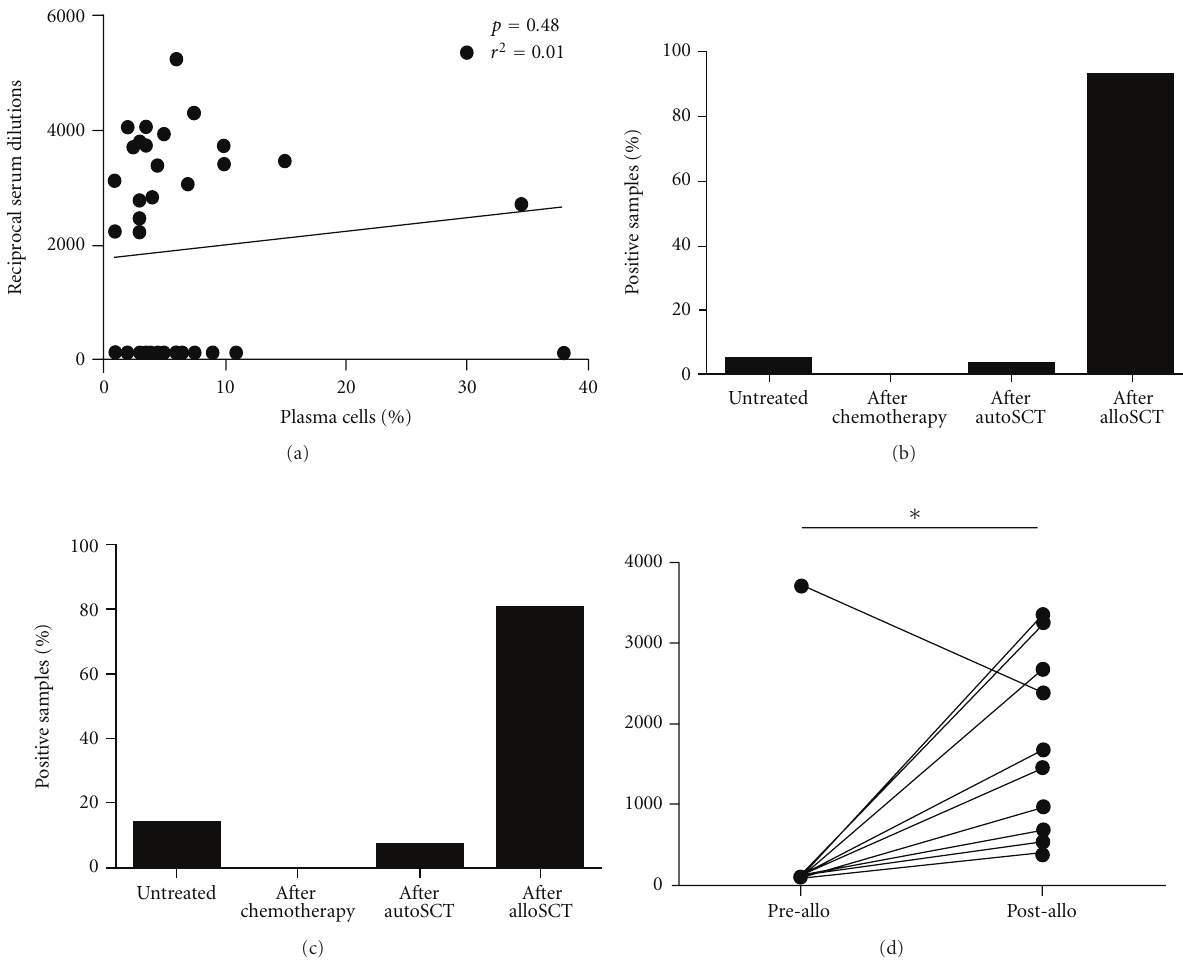
Figure 4: (a) Correlation analysis between the percentage of plasma cells found in the BM of MM patients with the corresponding SOX2- specific antibody titers. For some patients several samples from di ff erent time points were analyzed. No significant correlation was found between these two parameters ( P = 0 . 4826, r = 0 . 01153). (b) Treatment-dependent distribution of SOX2-positive samples and SOX2- positive patients. 92% (63 of 68) of all SOX2-antibody-positive samples were collected after alloSCT, while 4% (3 of 68) and 2.9% (2 of 68) were collected at time of diagnosis or after chemotherapy, respectively. 80% of SOX2-antibody-positive patients had received alloSCT as maximum treatment, while 13% (2 of 15) and 7% (1 of 15) were untreated or had received autoSCT, respectively. (c) Comparison between SOX2-specific antibody titers before and after alloSCT. Mean values of titers for the respective patient prior and after alloSCT are shown. From 12 SOX2-antibody-positive patients, pre-alloSCT samples were available for 10 patients. 9 of those patients were antibody negative prior to alloSCT and subsequently seroconverted. SOX2-specific antibody titers were significantly higher after alloSCT when compared to pre-alloSCT titers ( P < 0 .